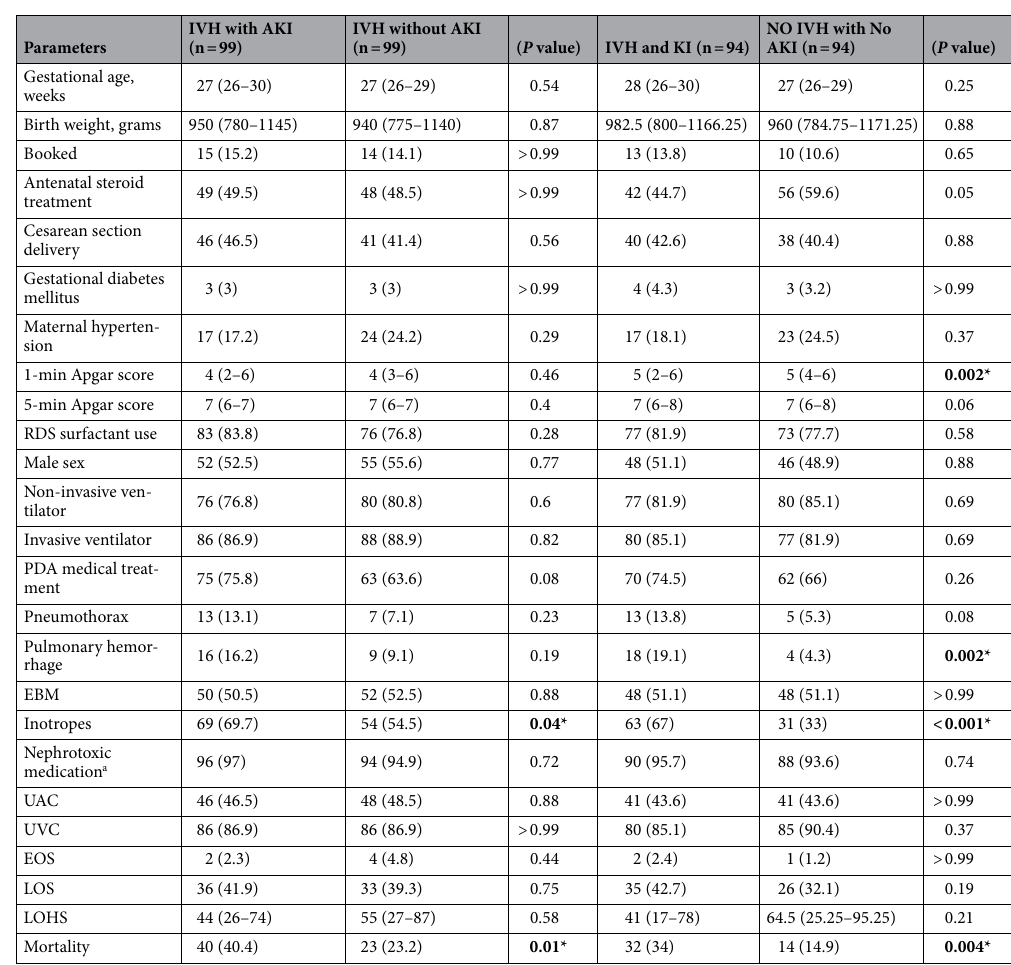
Table 4. Comparison of demographic, clinical, and maternal characteristics among infants with and without IVH and/or AKI after matching. Data are presented as median (IQR), or number (%), as appropriate.